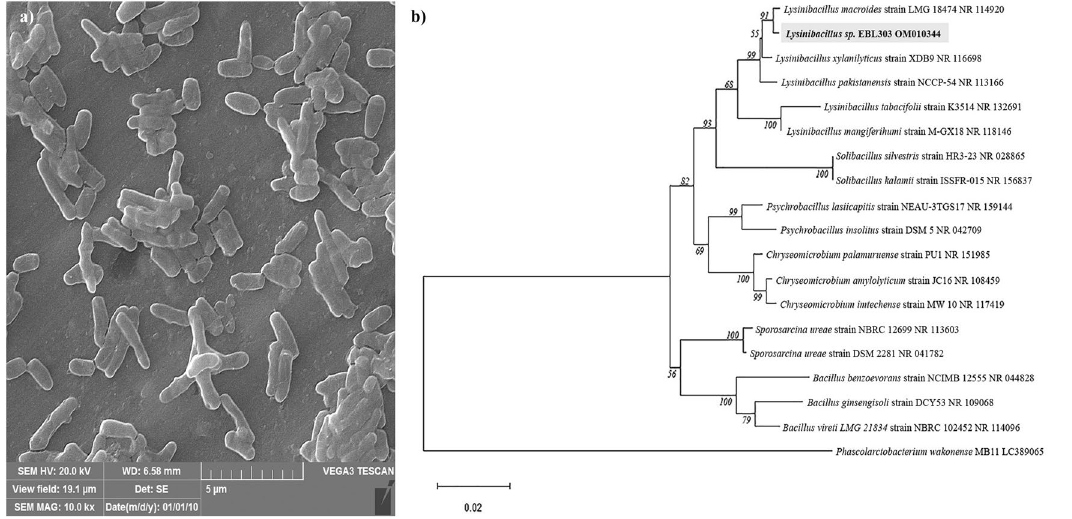
Figure 1. SEM micrograph of strain EBL303 ( a ) and Phylogenetic tree of Lysinibacillus sp. EBL303 ( b ) and its related sequences from the NCBI database.